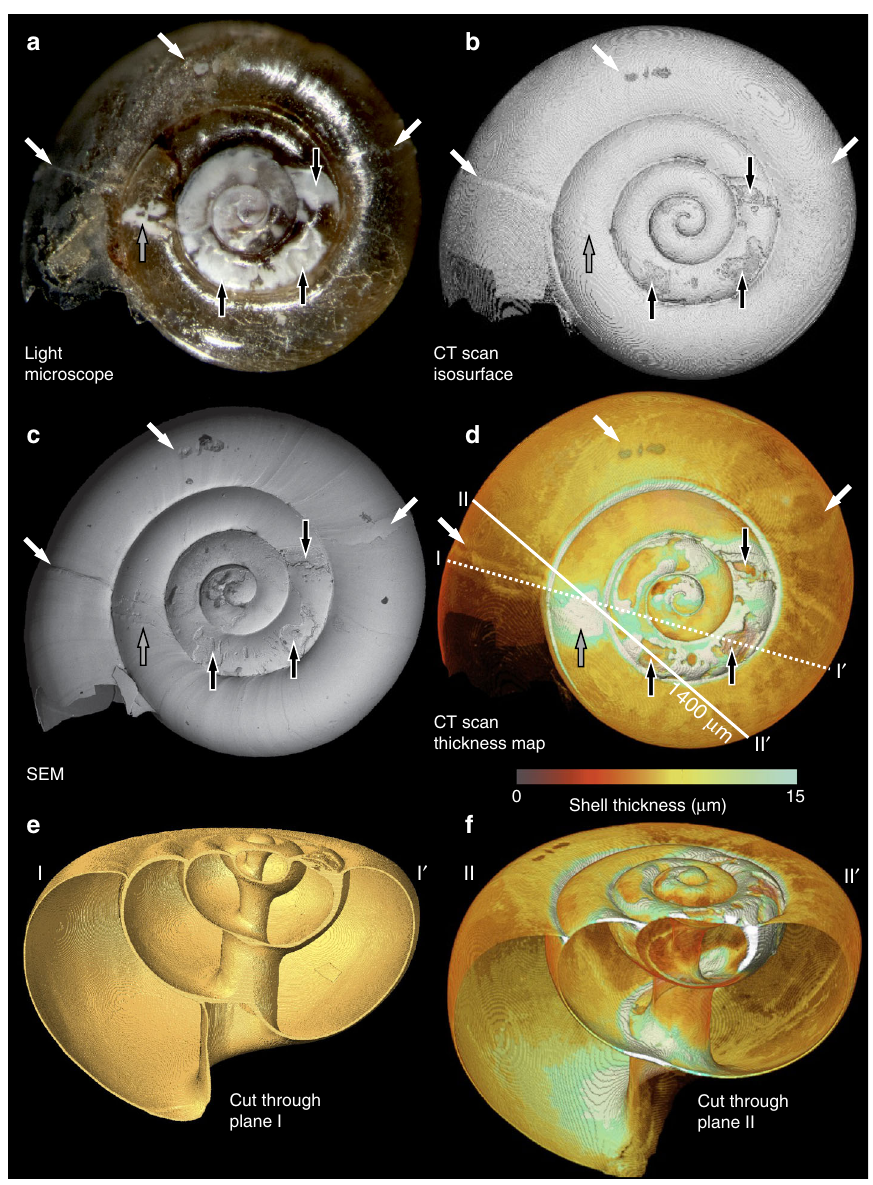
Fig. 2 Comparison of imaging methods of L. helicina specimen to demonstrate shell thickening in response to surface damage and dissolution. a Light microscopic image; b isosurface rendering of the surface of the shell; c SEM; d CT-scan thickness map; e , f cut-through images along planes I – I ’ and II – II ’ indicated in d , respectively. The shell thickness colour scale used in d and f is indicated within the range 0 – 15 μ m. Shell exceeding a thickness of 15 μ m appears white. Black arrows indicate areas of deep surface damage in the inner whorls with evidence of dissolution and associated shell thickening observed in SEM and CT images, respectively. Grey arrow indicates shell fractures in the penultimate whorl with no evidence of dissolution but associated shell thickening observed. White arrows indicate fractures and mechanical damage in the fi nal whorl with no evidence of dissolution and no associated shell thickening